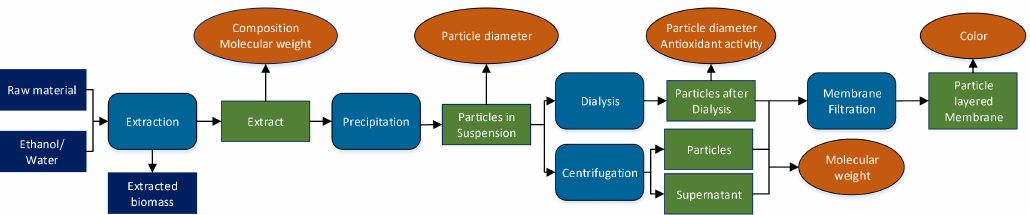
Figure 1. Schematic of the experimental plan conducted for each pretreatment condition and raw material. The analyzed process fractions are depicted in